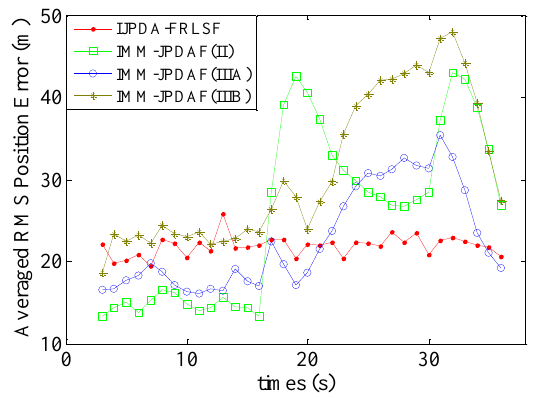
Figure 9 . The estimates of for target II.